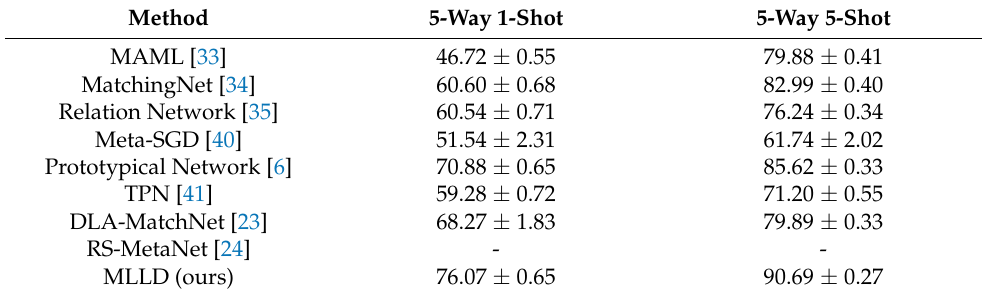
Table 3. Classification accuracy on the WHU-RS19 dataset.